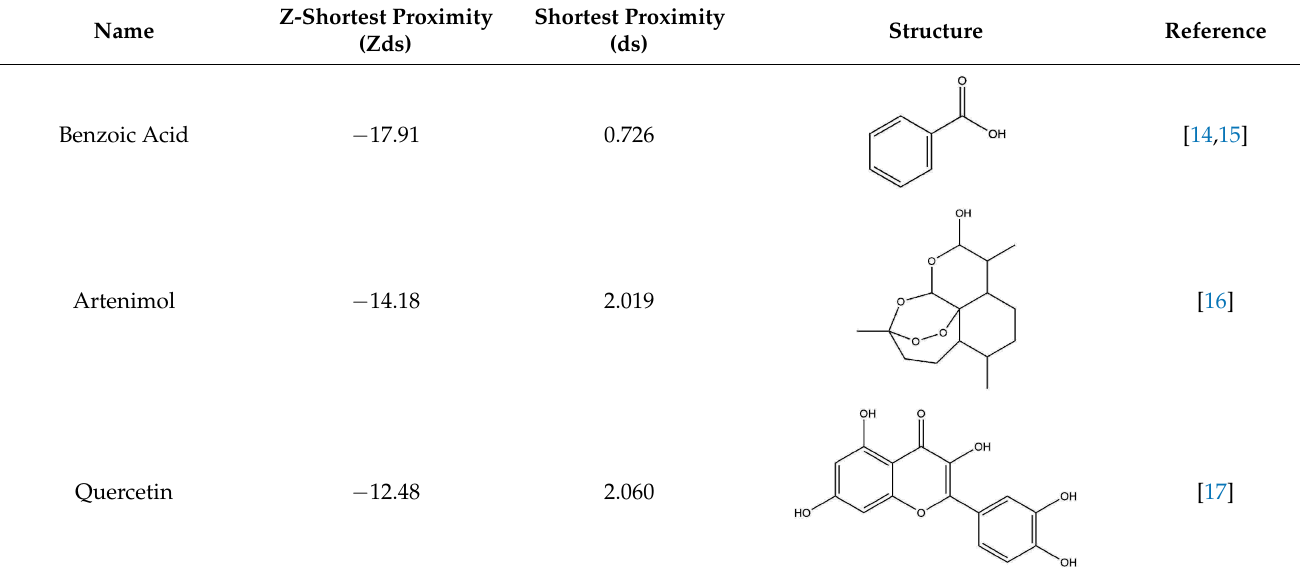
Figure 6. Characterizing the roles of proximity on drug repurposing for anti-pulmonary fibrosis drugs. ( A ) Schematic representation of the method. ( B ) Distribution of different proximity measures. ( C ) Comparison of proximity, Zds, between drugs with known and unknown anti-pulmonary fibrosis effects. ( D ) Analysis of the predictive performance of Zds on anti-pulmonary fibrosis effects using the ROC curve. Table 1. Selected top-ranked drugs with highly anti-pulmonary fibrosis potential.